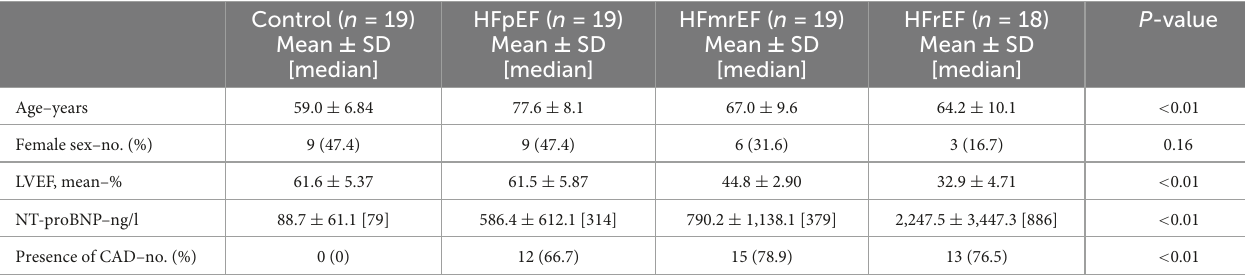
TABLE 1 Baseline characteristics by study subgroup.